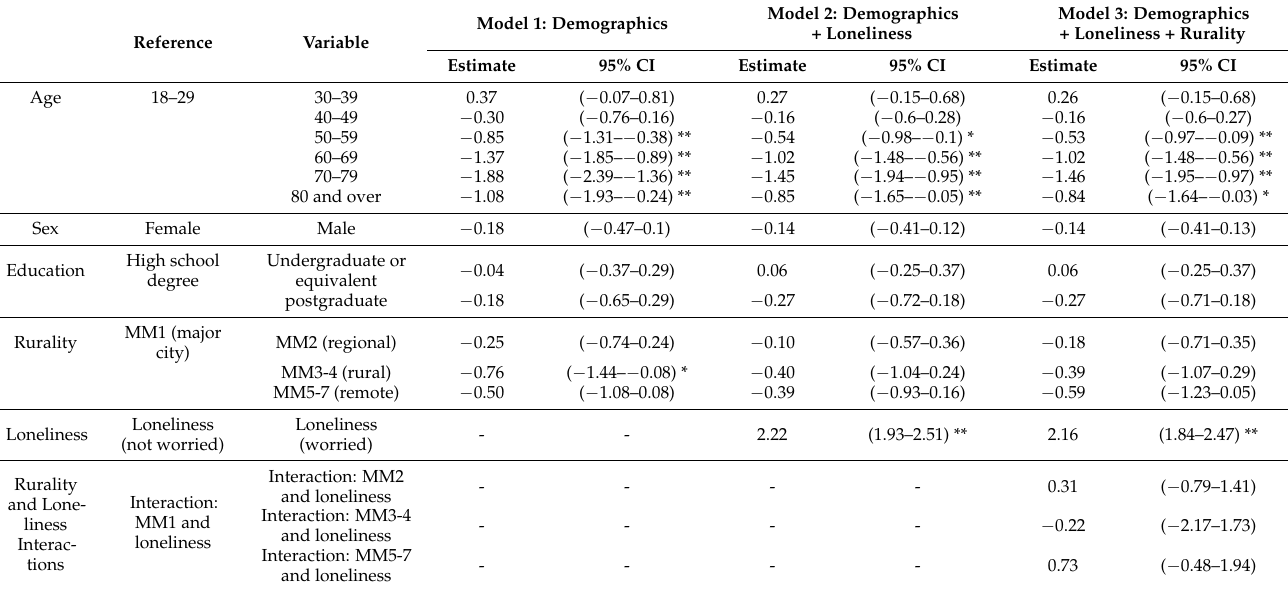
Table 3. General linear regression modelling of factors associated with